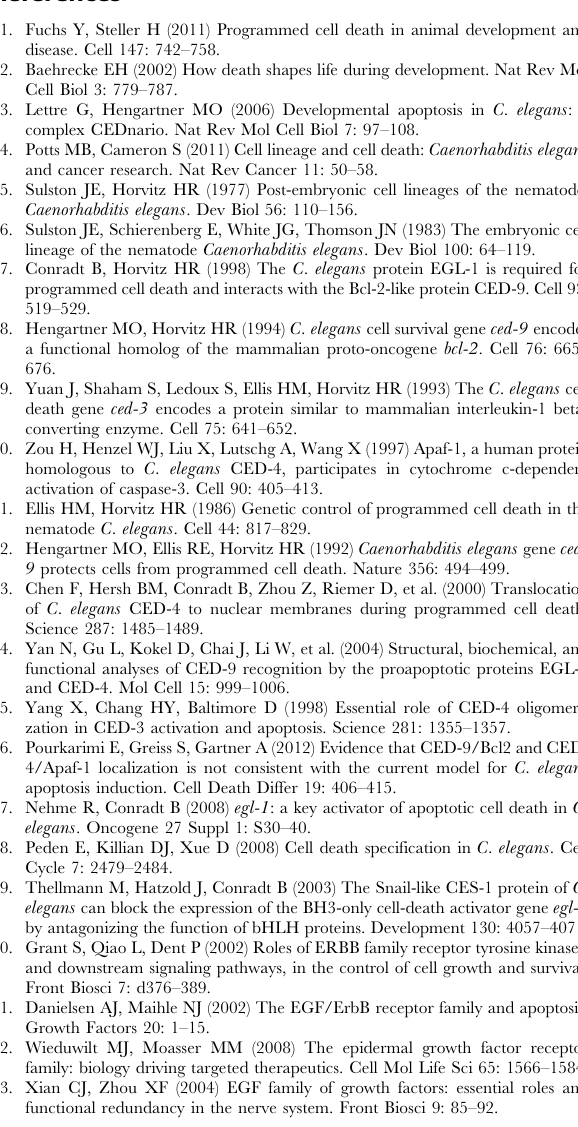
Table S1 Analysis of extra surviving cells in the phary- ced-3(n2427) sensitized background. Table S2 lin-3 requires let-23 and the core PCD pathway (PDF) Table S3 Mutants defective in the LET-60-MPK-1 path- (PDF) Table S4 The PI3K pathway and PLC genes are not